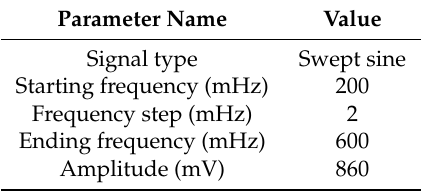
Table 1. SR780 analyzer measurement parameters for the electrode’s voltage transfer